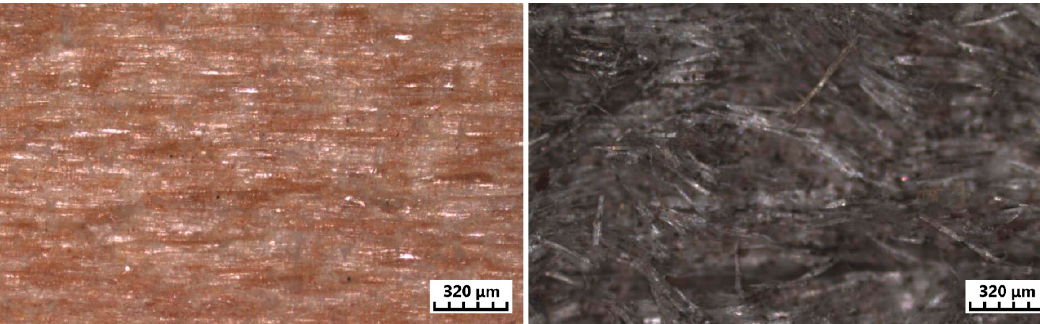
Figure 12. Confocal laser scanning microscopy of maple wood before and after 2 years of weathering (detail).